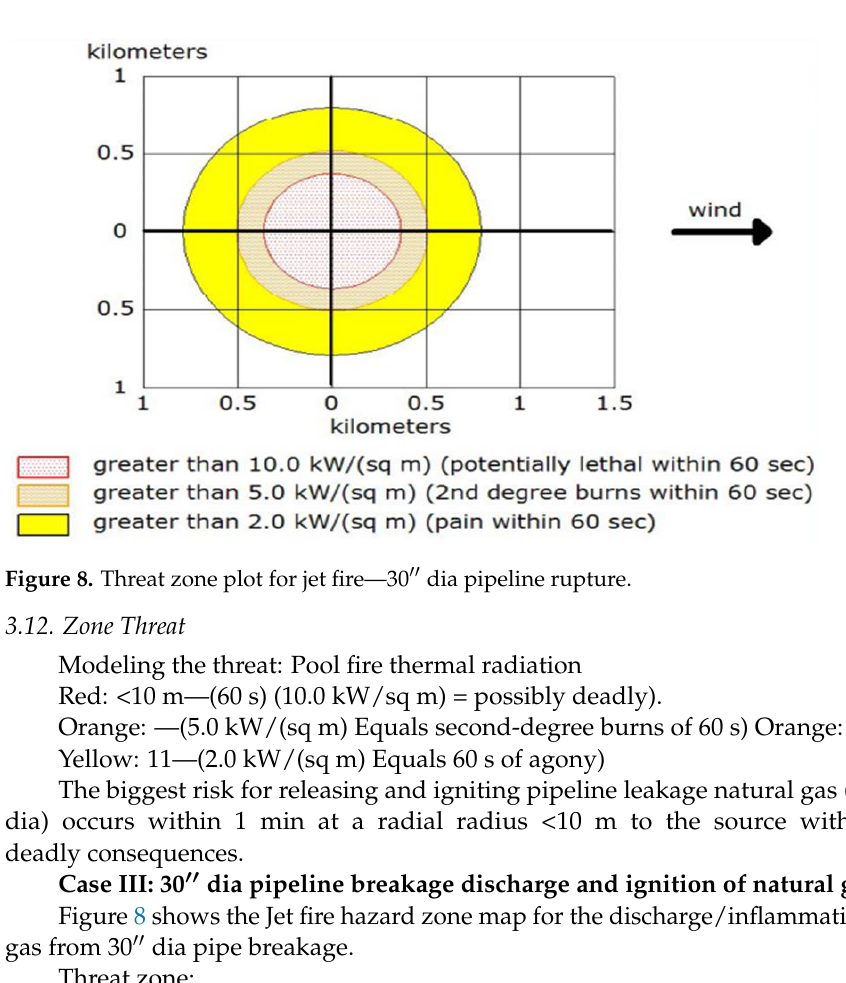
Figure 7. DIA pipeline zone plot (30 inches) 1 ″ DIA leak.